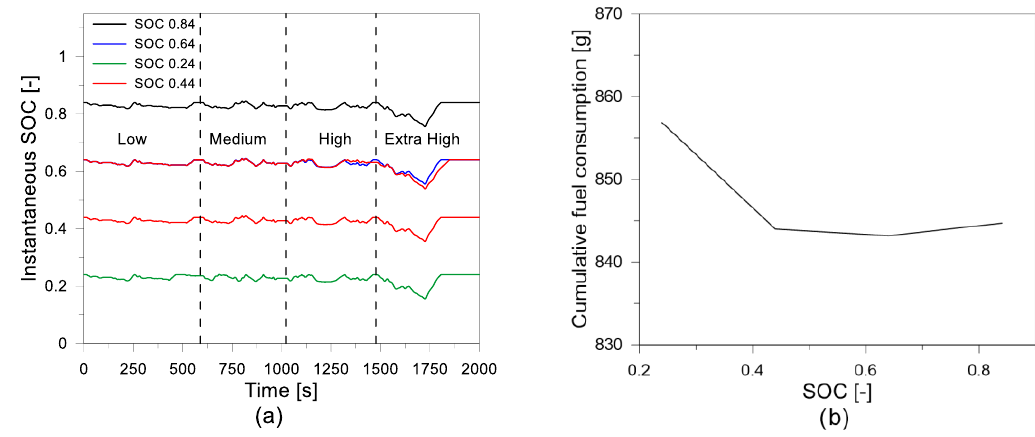
Figure 8. Instantaneous state of charge (SOC) ( a ) and final fuel consumption ( b ) for different initial SOC at the worldwide harmonized light vehicles test cycle (WLTC) driving cycle.